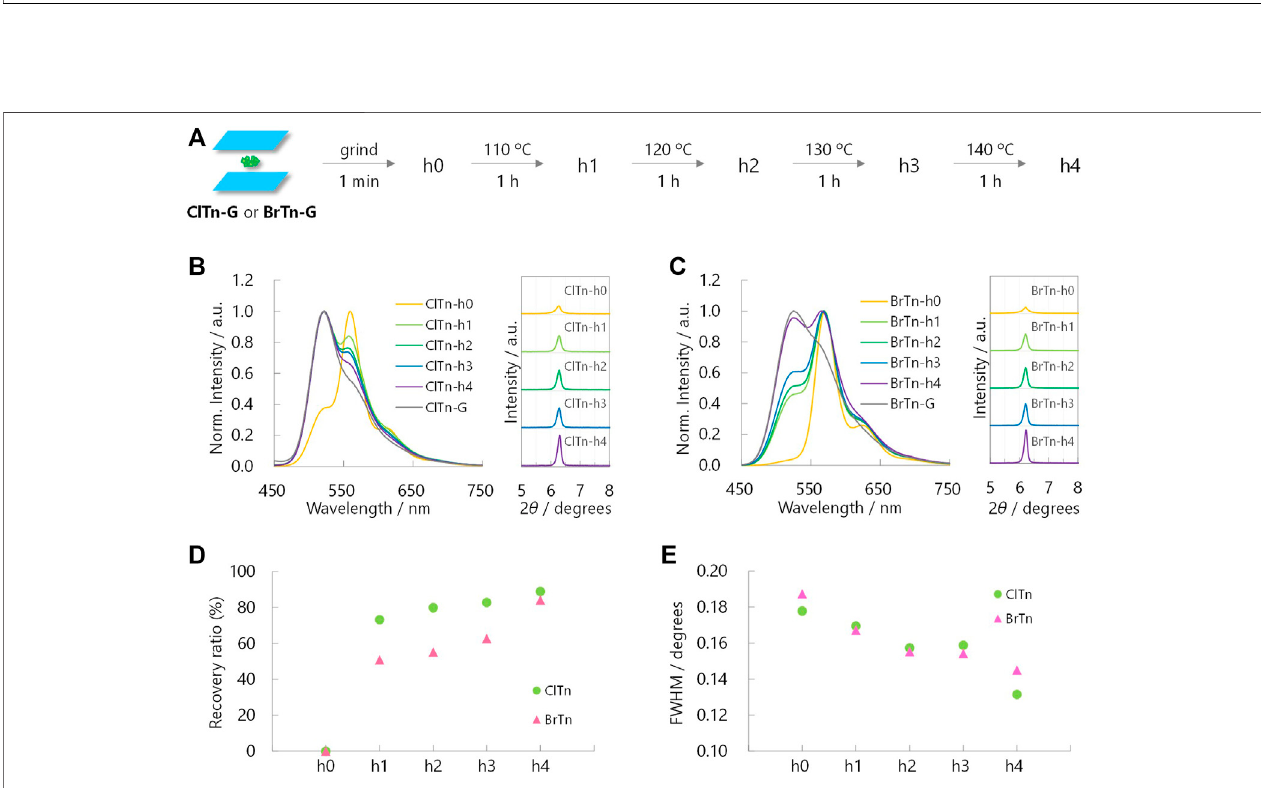
FIGURE 8 | (A) Sample preparation for heat-induced-recovery experiments. (B, C) Normalized PL spectra (left, λ ex (cid:2) 320 nm) and corresponding PXRD pro fi les (right) of (B) ClTn-Y and (C) BrTn-Y upon heating. (D) Sensitivity of the RTP color and (E) FWHMs of the PXRD peaks at 2 θ (cid:2) ∼ 6 ° toward the thermal stimulation. See Experimental Section for de fi nition of the recovery